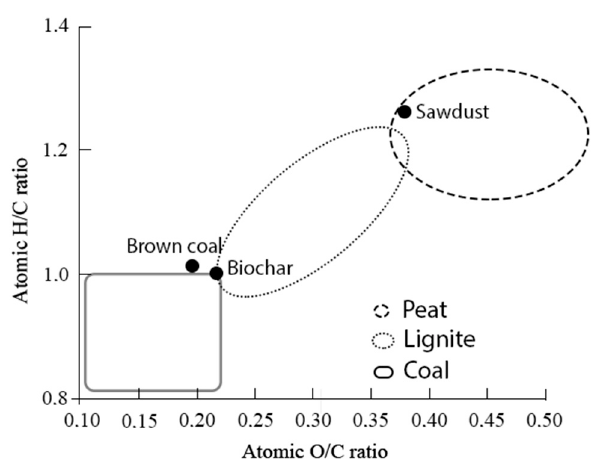
Figure 1. Van Krevelen diagram.